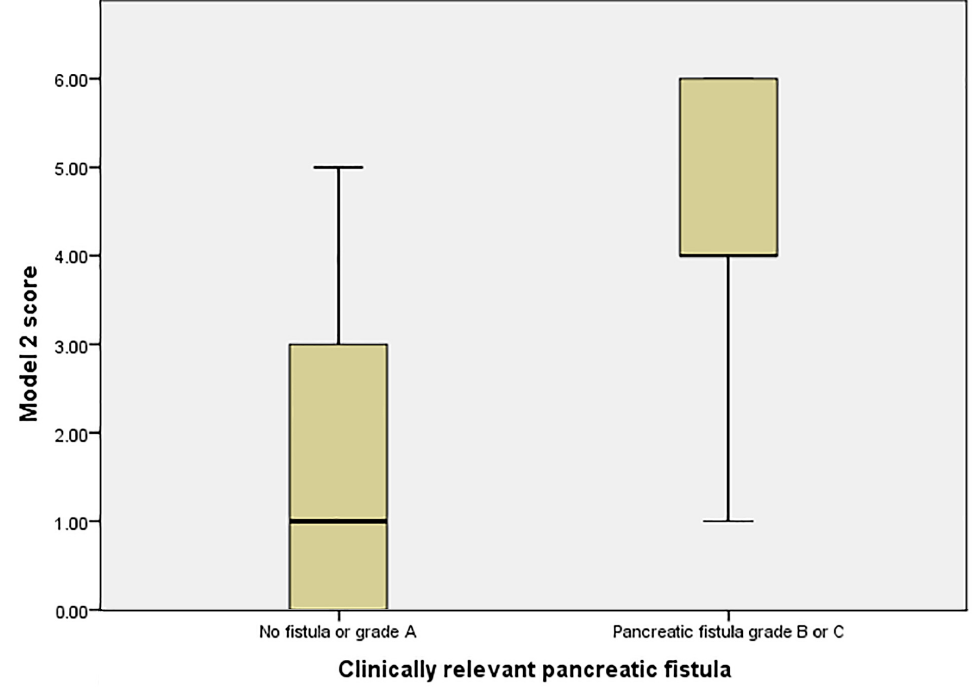
Figure 6. Risk groups for CRPF in Model 2. 6.